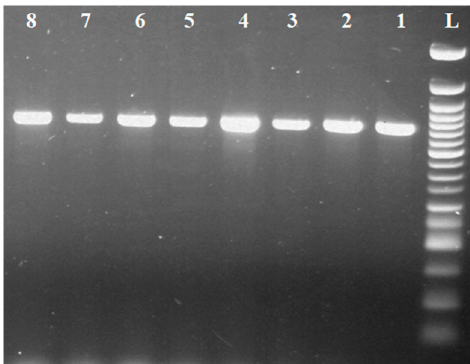
Figure 5. Identification of the ermB gene in Lactobacillus sp. L: 50 bp standard; line 1: Staphylococcus aureus reference strain CCM 4223 (639 bp); lines 2–3: isolates of Lb. zeae with ermB gene; lines 4-8: isolates of Lb. johnsonii with ermB gene.